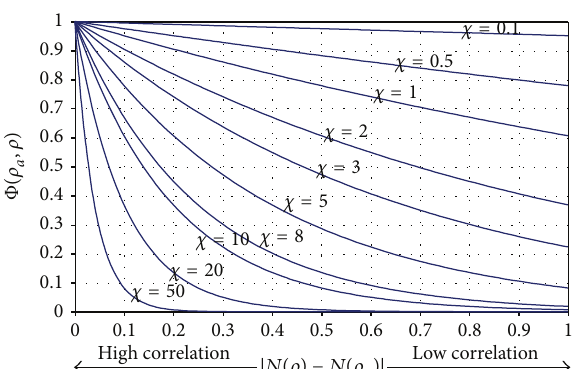
Figure 4: Pattern of filtering function Φ at different values of parameter 𝜒 .